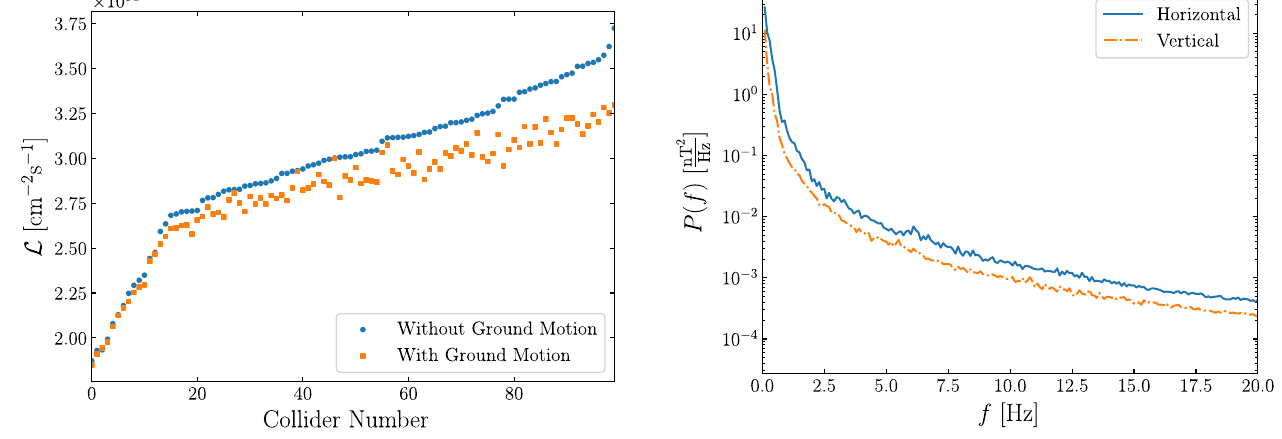
FIG. 15. PSD P ð f Þ vs frequency f of the stray field during a geomagnetic storm in the horizontal (solid blue) and vertical (dot- dashed orange) direction with respect to the beam.